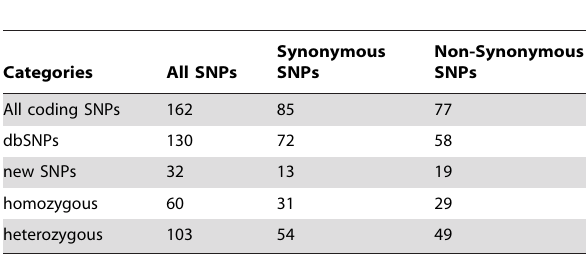
Table 4. SNPs in the coding sequences of the genes from the target region.